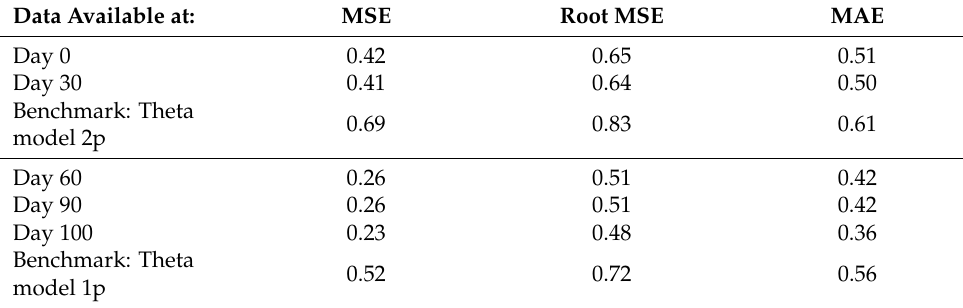
Table A3. Mean squared and absolute out-of-sample forecast errors of the median of Models (1) to (6) conditioned with available data over the current quarter after last-error correction (full sample